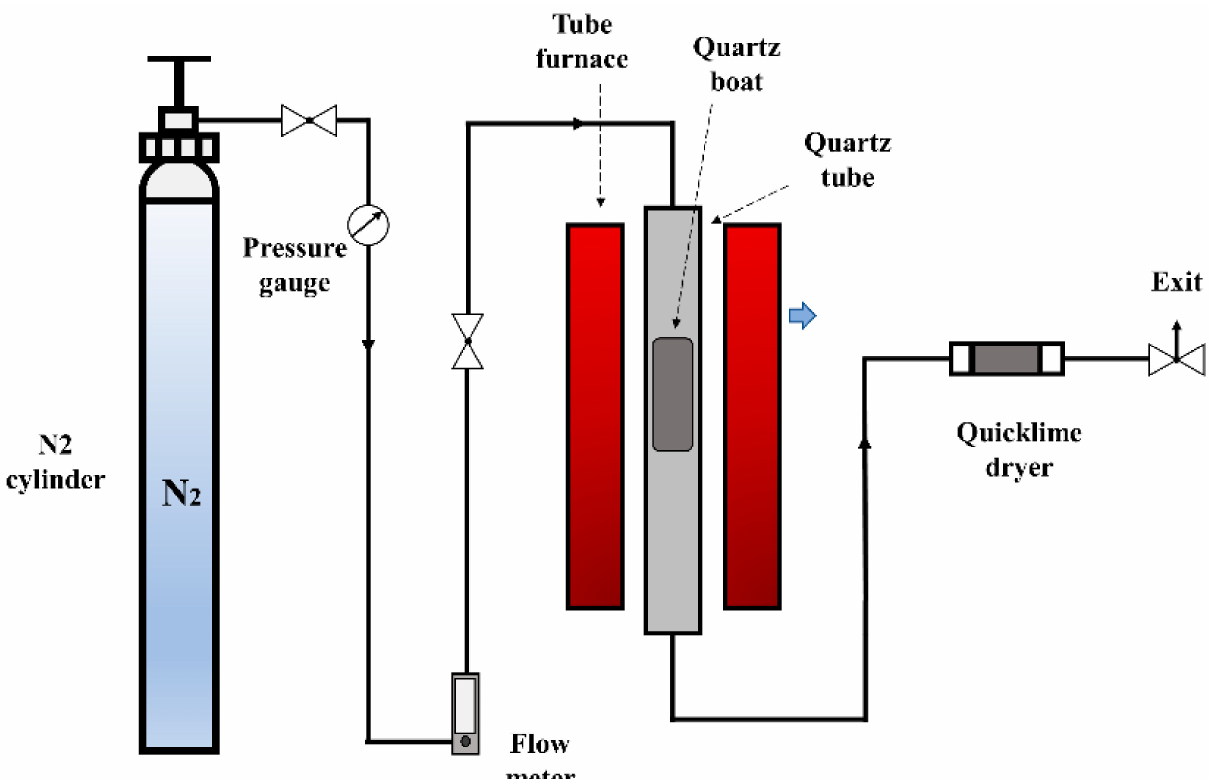
Figure 3. Schematic diagram of the pyrolysis